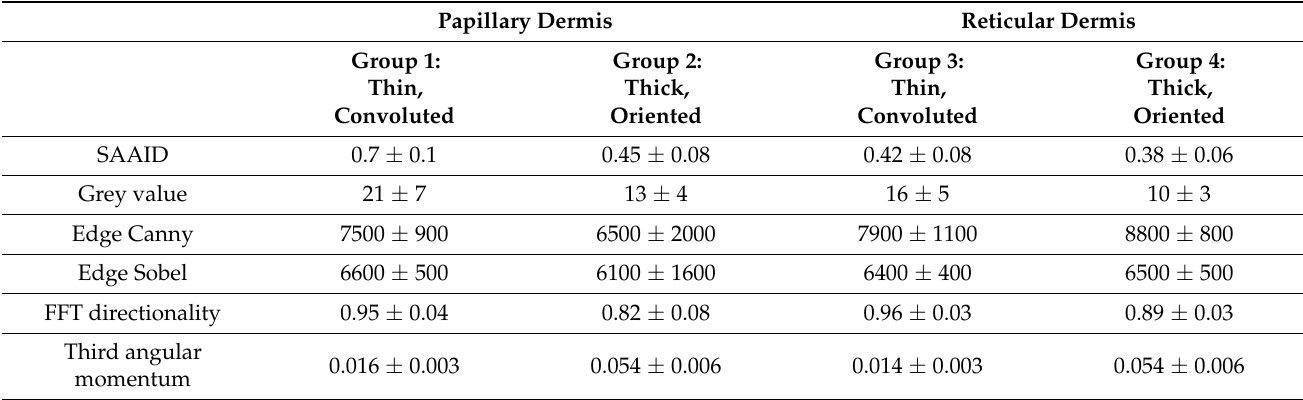
Table 1. Summary of the results of the applied image analysis methods for the papillary and reticular dermis. Values were calculated from the training datasets as described before. Groups 1 and 2 were extracted from a depth of 60–85 µ m on the volar forearm, and groups 3 and 4 were extracted from 85–120 µ m on the volar forearm.